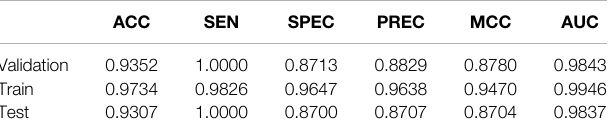
TABLE 3 | Results of independent